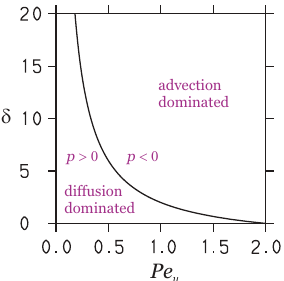
Figure 4. Parameter regimes: the black curve shows Pe y values for which p = 2/ δ − ( 1 + 2/ δ ) Pe y /2 =